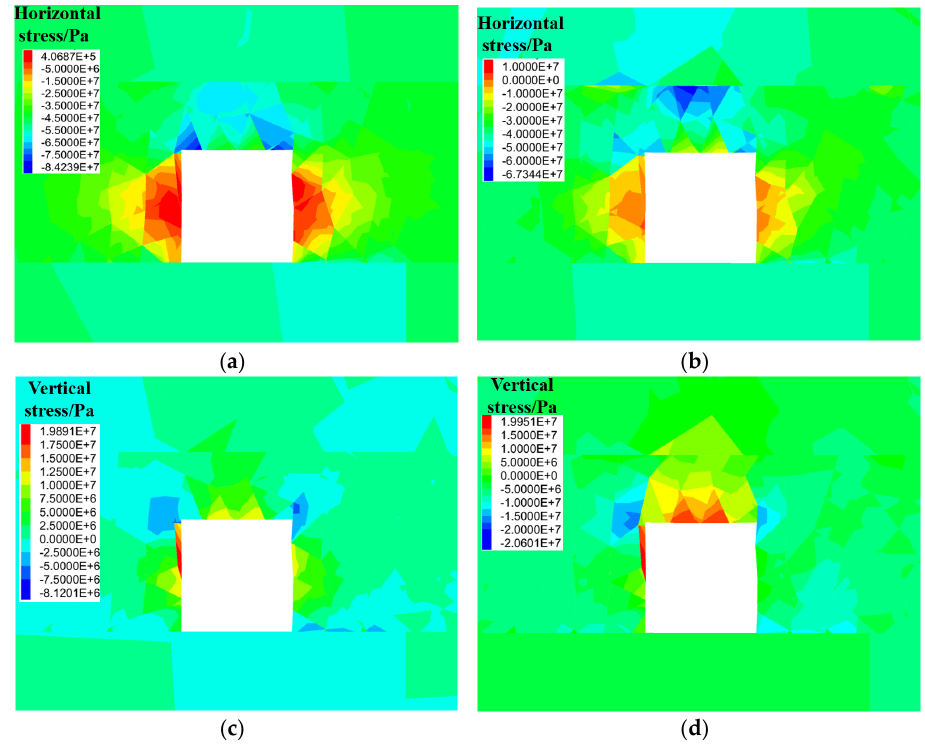
Figure 3. Stress redistribution surrounding the roadway before and after goaf formation: ( a ) Hor ‐ izontal stress before goaf formation; ( b ) Horizontal stress after goaf formation; ( c ) Vertical stress before goaf formation; ( d ) Vertical stress after goaf formation.